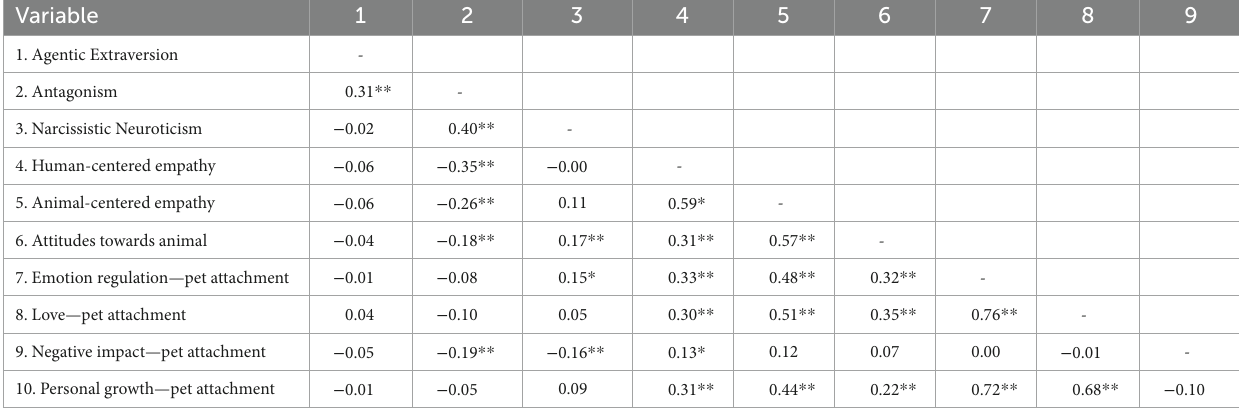
TABLE 1 Zero-order correlations between narcissism and animal- and human-centered empathy, pet attachment, and attitude towards animals.